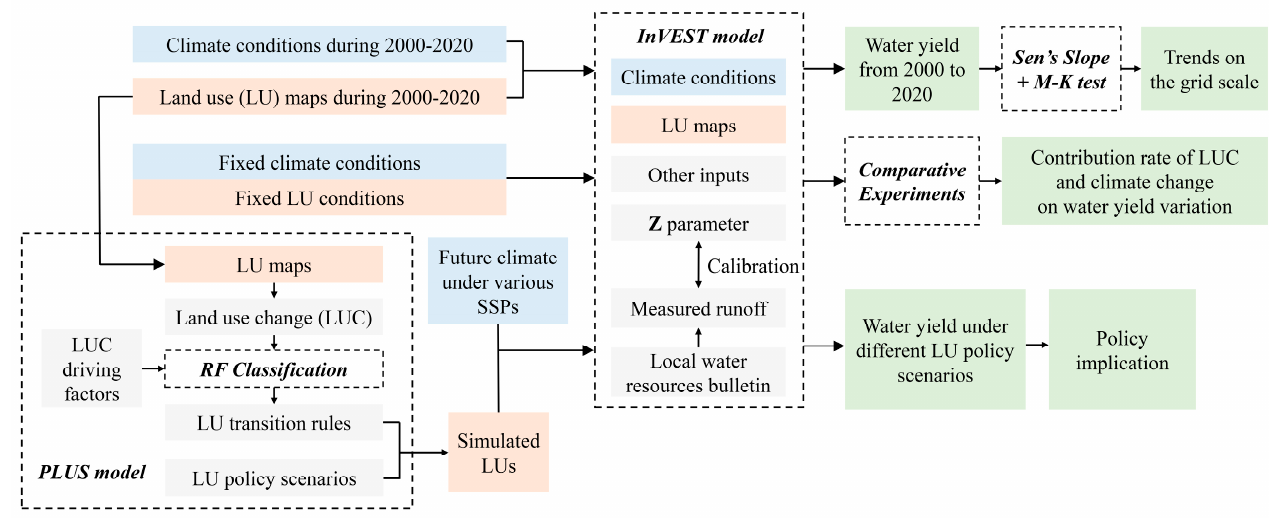
Figure 1. Location and digital elevation model of the HBOY region.